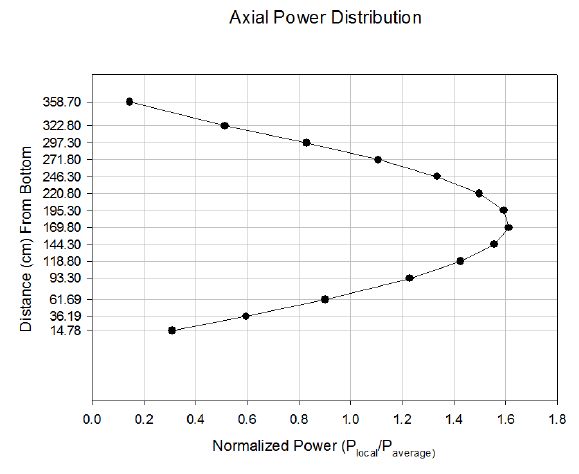
Figure 13. Maximum energy deposited in fuel pin.